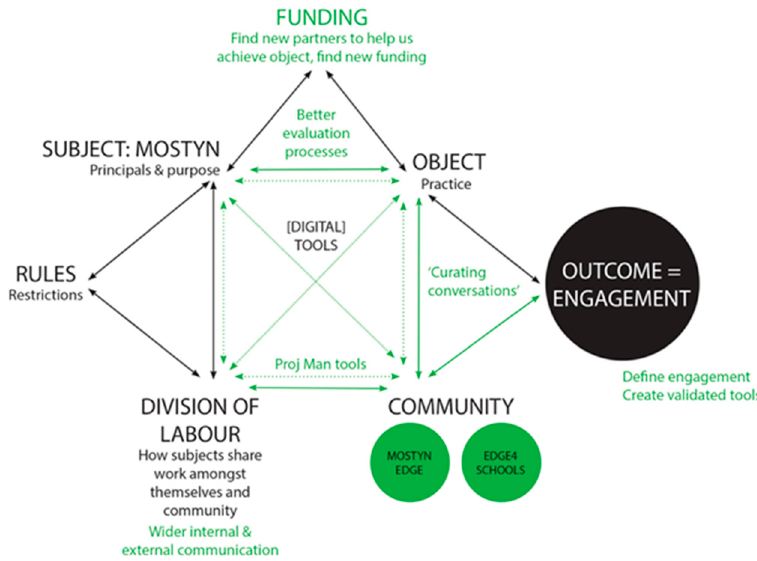
Figure 3. Opportunities for digital interventions at MOSTYN within proposed experimental Activity System 1 identified by Harding as part of this research, 2018.